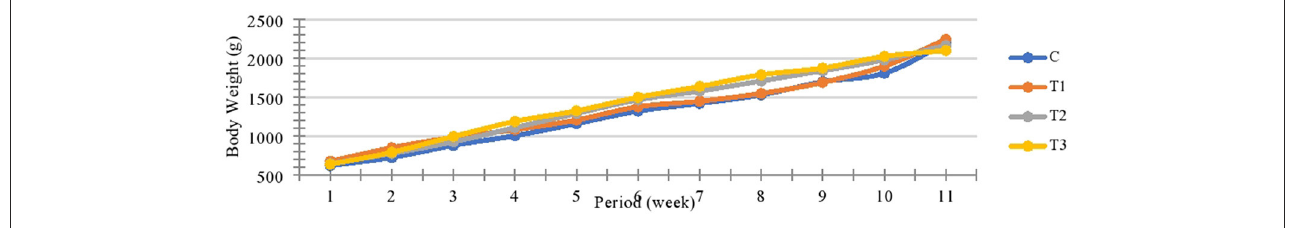
FIGURE1 Growth curve pattern of different groups through the experimental period (C: control; T1: 1% mealworm frass in the diet; T2: 2% mealworm frass in diet; and T3: 3% mealworm frass in diet).